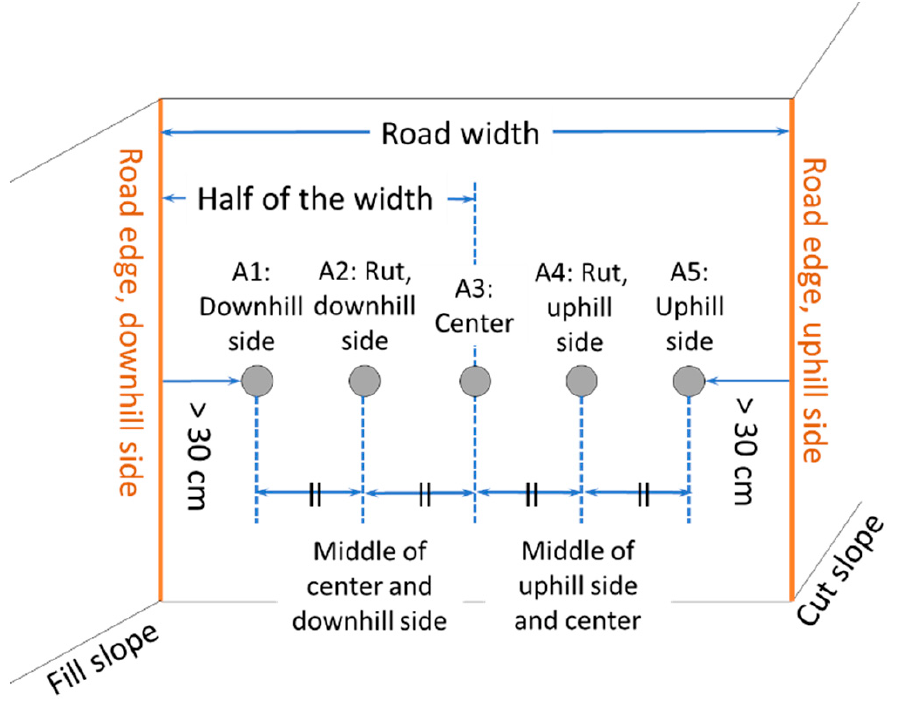
Figure 6. Measuring points on the spur road at each sample point of Site 1. The number of repetitions of the measurement was set to five so that the distance between every two points would be the same. However, because of the slightly shorter section length of A3, the number of repetitions of A3 was four. Therefore, 24 points were investigated for Site 1 in total.